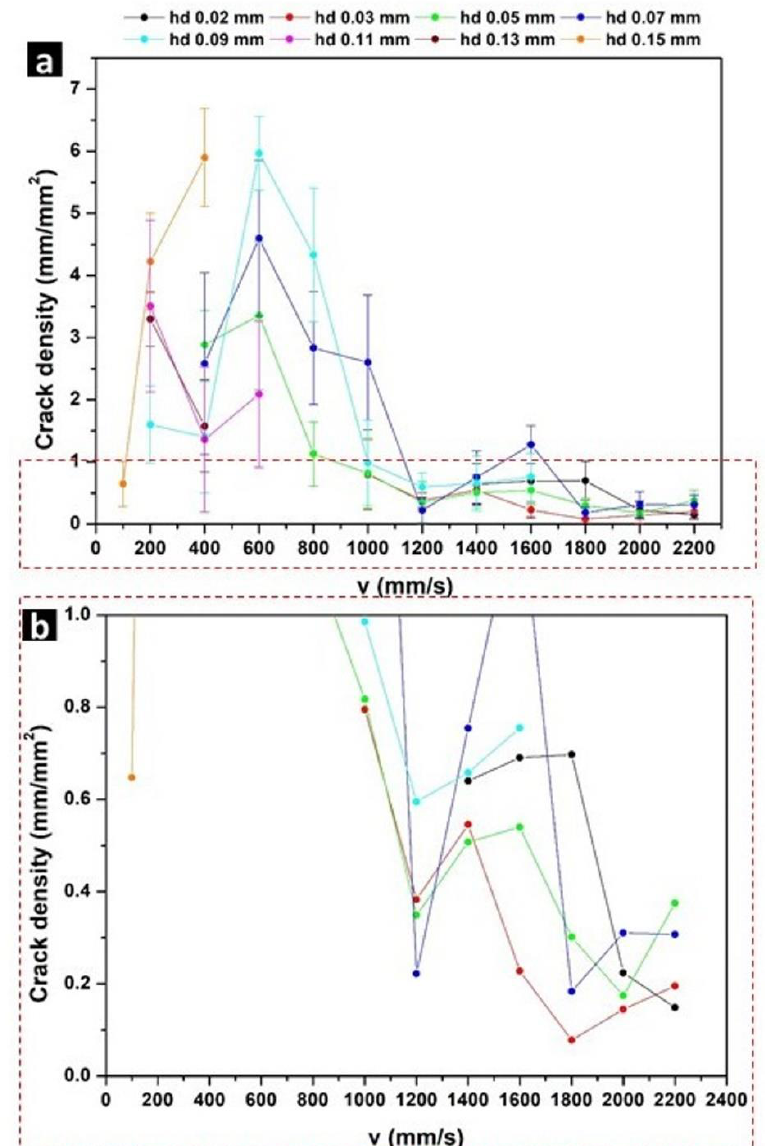
Figure 7. ( a ) Effect of scanning speed and hatching distance on the cracking density of LPBFed IN939; ( b ) Zoom of cracking density lower than 1 mm/mm 2 .